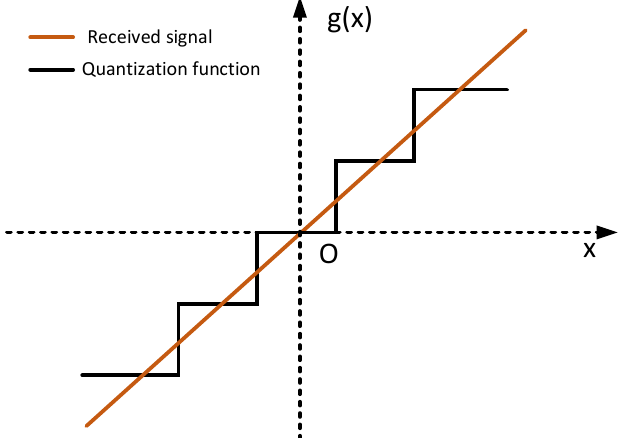
Figure 2. The quantization